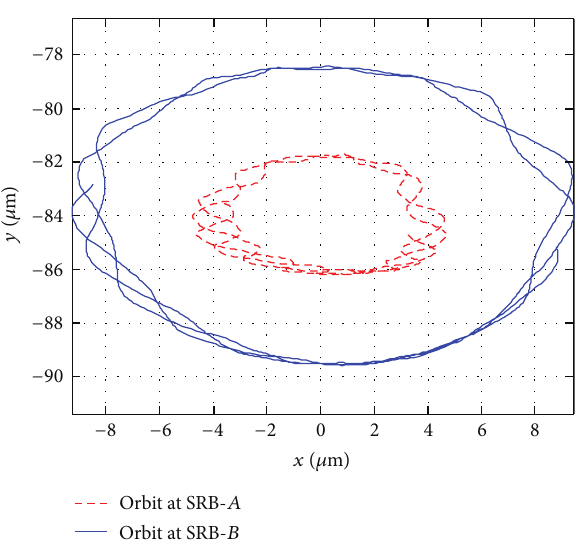
Figure 14: Rotor axis orbits at SRB 𝐴 and 𝐵